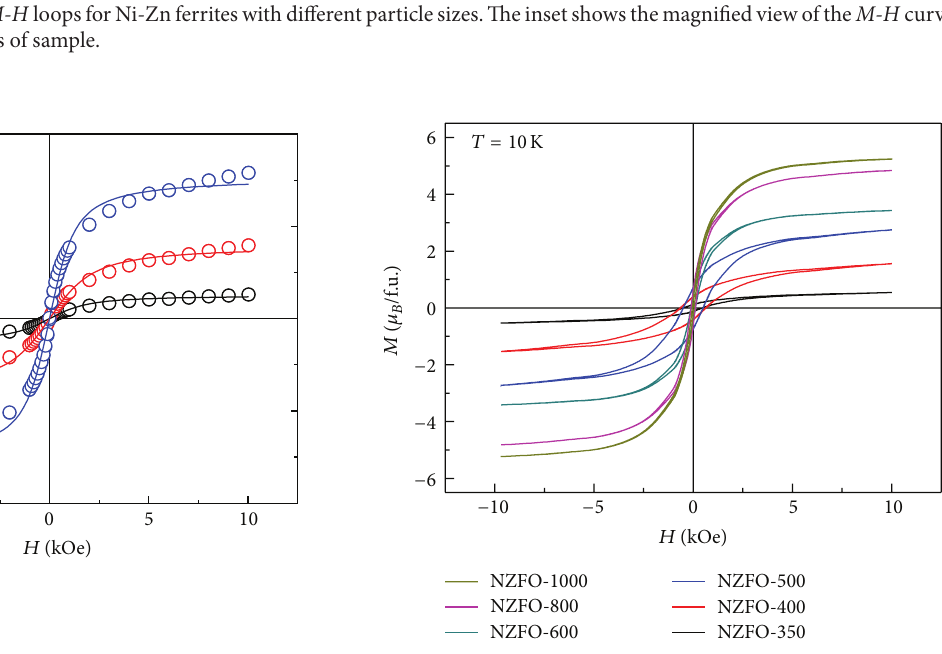
Figure 5: The nonlinear curve fit of Langevin function for NZFO- 350, NZFO-400, and NZFO-600.